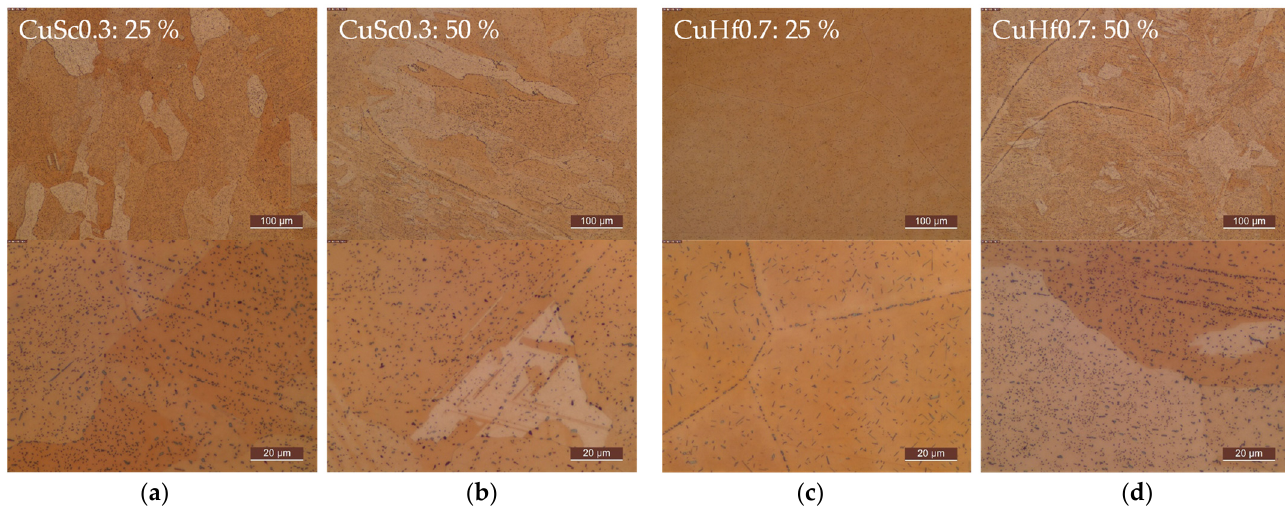
Figure A11. Microstructure evolution (condition 2) during DSC measurements in the optical mi- croscope: ( a , b ) specimen of CuSc0.3 with 25% and 50% cold rolling; ( c , d ) specimen of CuHf0.7 with 25% and 50% cold rolling.